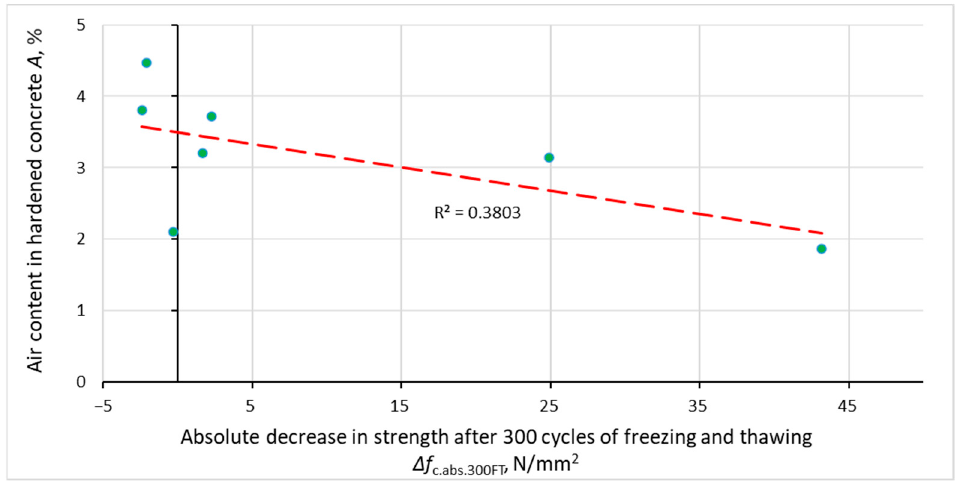
Figure 8. Dependence of the decrease in the compressive strength of concrete after 300 cycles of freezing and thawing on the total amount of air in the hardened concrete.